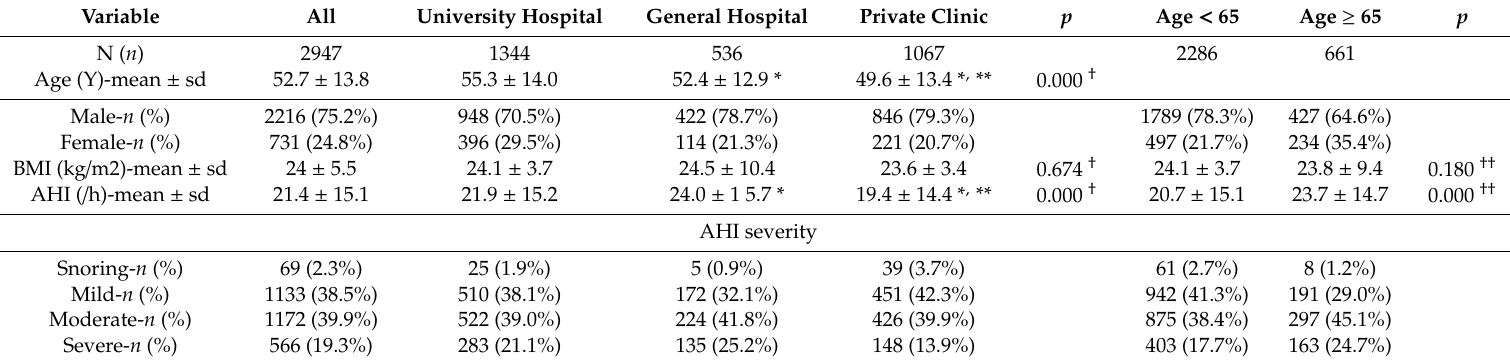
Table 1. Patient characteristics.